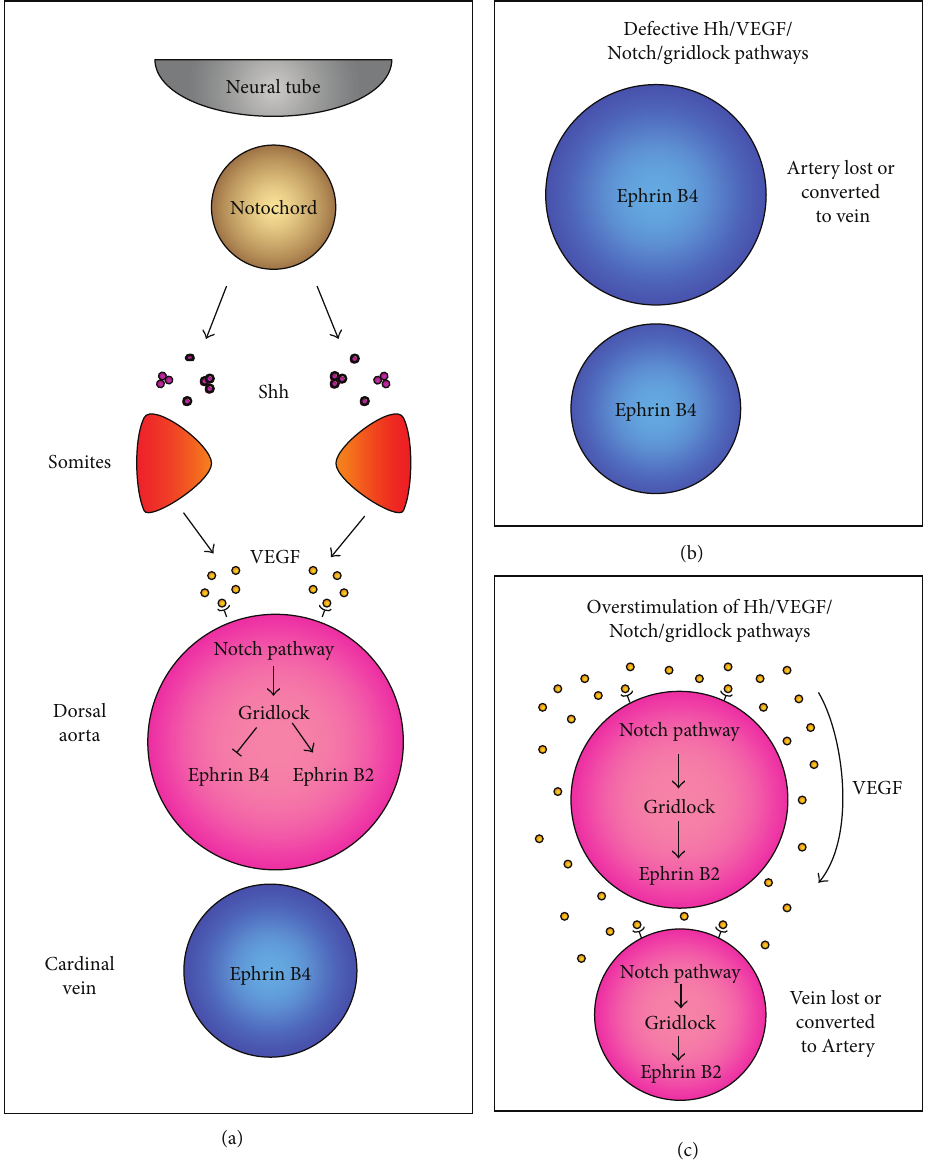
Figure3:Signallingcascadeinvolvedindeterminingarterial-venousidentityinzebrafish.(a)Shhfromthenotochordinduces vegf expression in somites, promoting arterial identity of endothelial cells in the aorta. The arterial ECs then stimulate Notch signalling in the surrounding cells resulting in an upregulation of gridlock and thus ephrin B2, conferring arterial identity of the aorta. (b) Impairment of the signalling hierarchy responsible for arterial-venous identity results in either loss of arterial identity in vessels or loss of arterial vessels entirely. (c) Overstimulation of one or more of the pathways in the signalling hierarchy responsible for arterial-venous identity results in either gain of arterial identity in venous vessels or loss of venous vessels